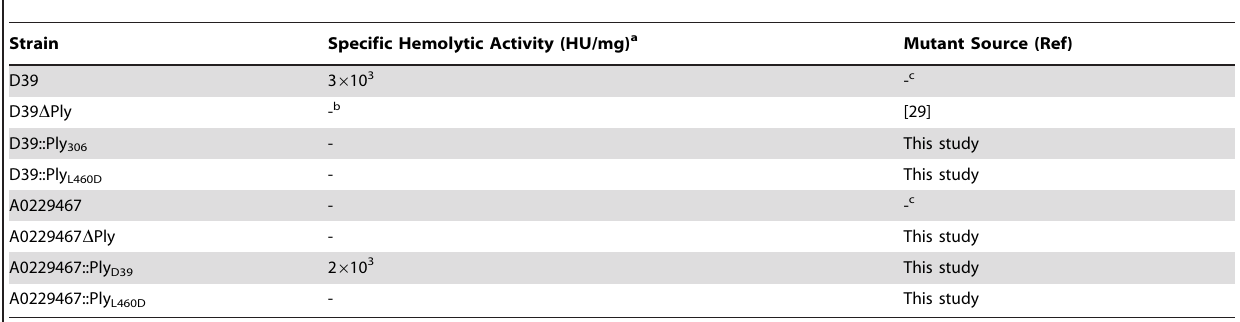
Table 1. Hemolytic activity of the strains used in this study.